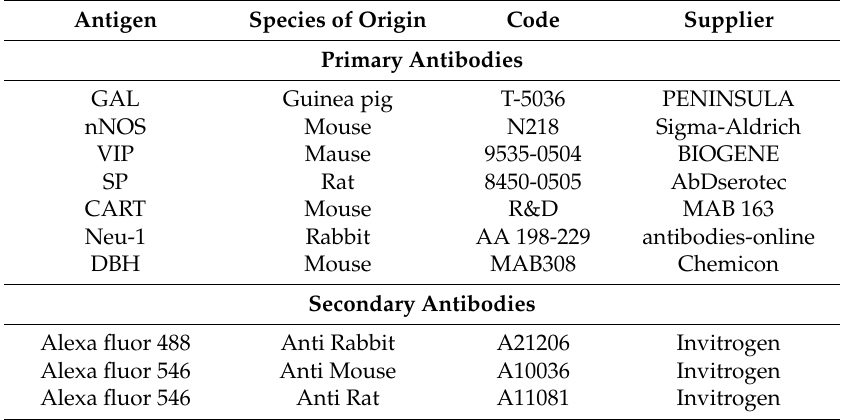
Table 3. Description of